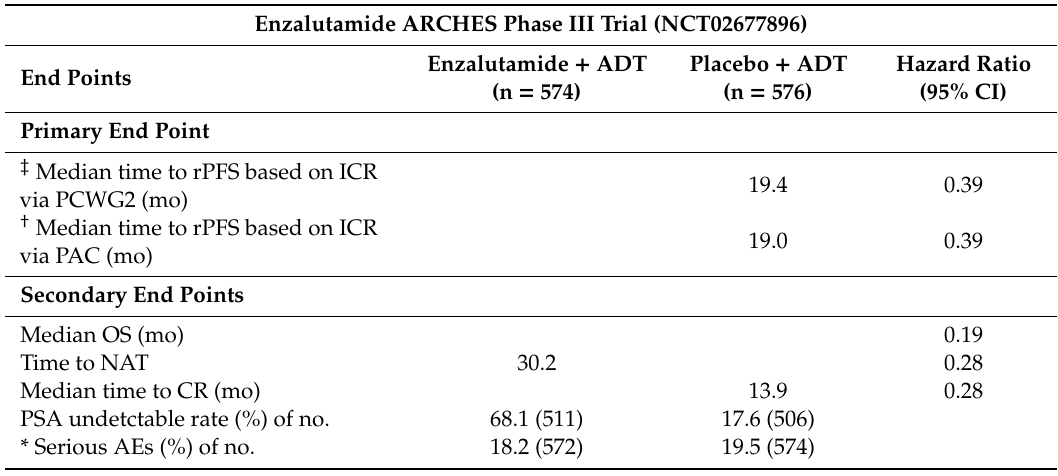
Table 6. Major therapeutic benefits brought by enzalutamide based on